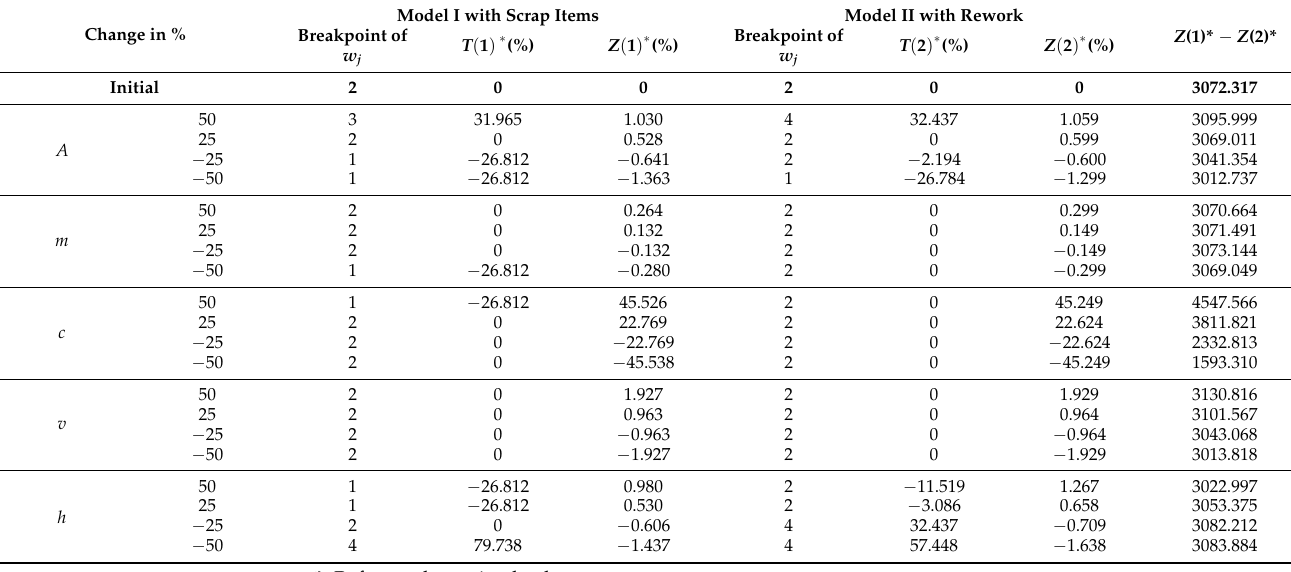
Table 7. Sensitivity analysis of the cost parameters.